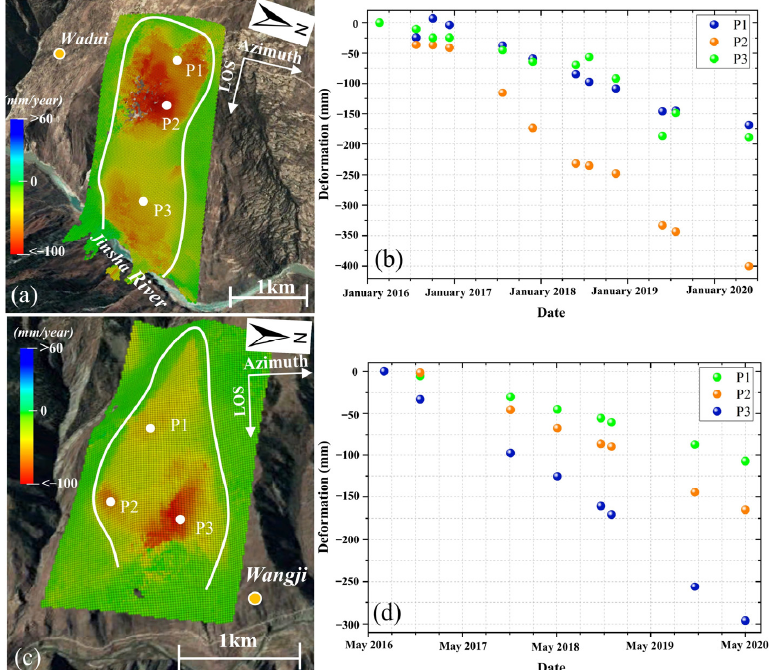
Figure 9. Deformation rates and time-series deformation of typical landslides. ( a ) Annual defor- mation rate of landslide G. ( b ) Time-series deformation of landslide G; points P1, P2, and P3 are marked in ( a ). ( c ) Annual deformation rate of landslide H. ( d ) Time-series deformation of landslide H; points P1, P2, and P3 are marked in ( c ). Locations of landslides G and H are shown in Figure 6.